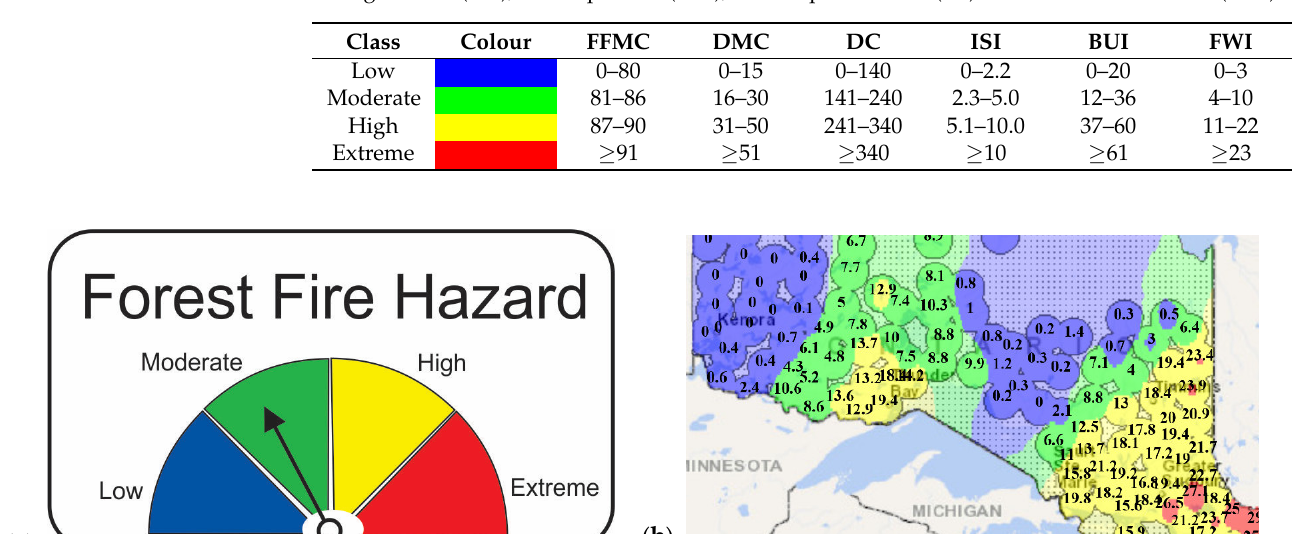
Figure 1. Examples of different displays of the Fire Weather Index (FWI) class used by the Ontario’s fire agency: ( a ) a public roadside sign; ( b ) an agency operational map showing interpolated, colour-coded FWI and the raw FWI values for each weather station.